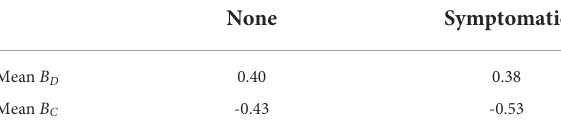
TABLE 3 Mean burstiness parameters for periods with and without the presence of